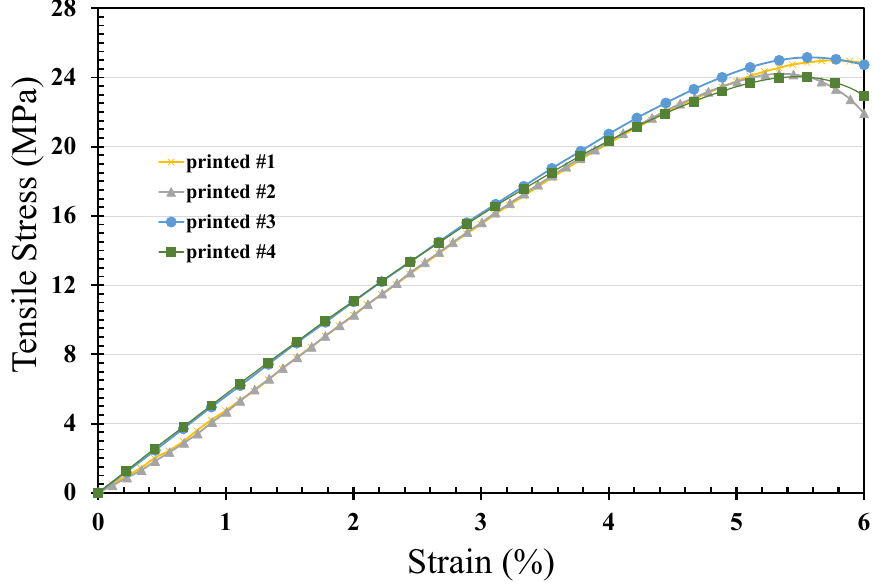
Figure 8. Yield strength of the printed specimen (ASTM D638; section, 3.16 × 2.7 mm; measured length, 15 mm; tension rate, 5 mm/min).